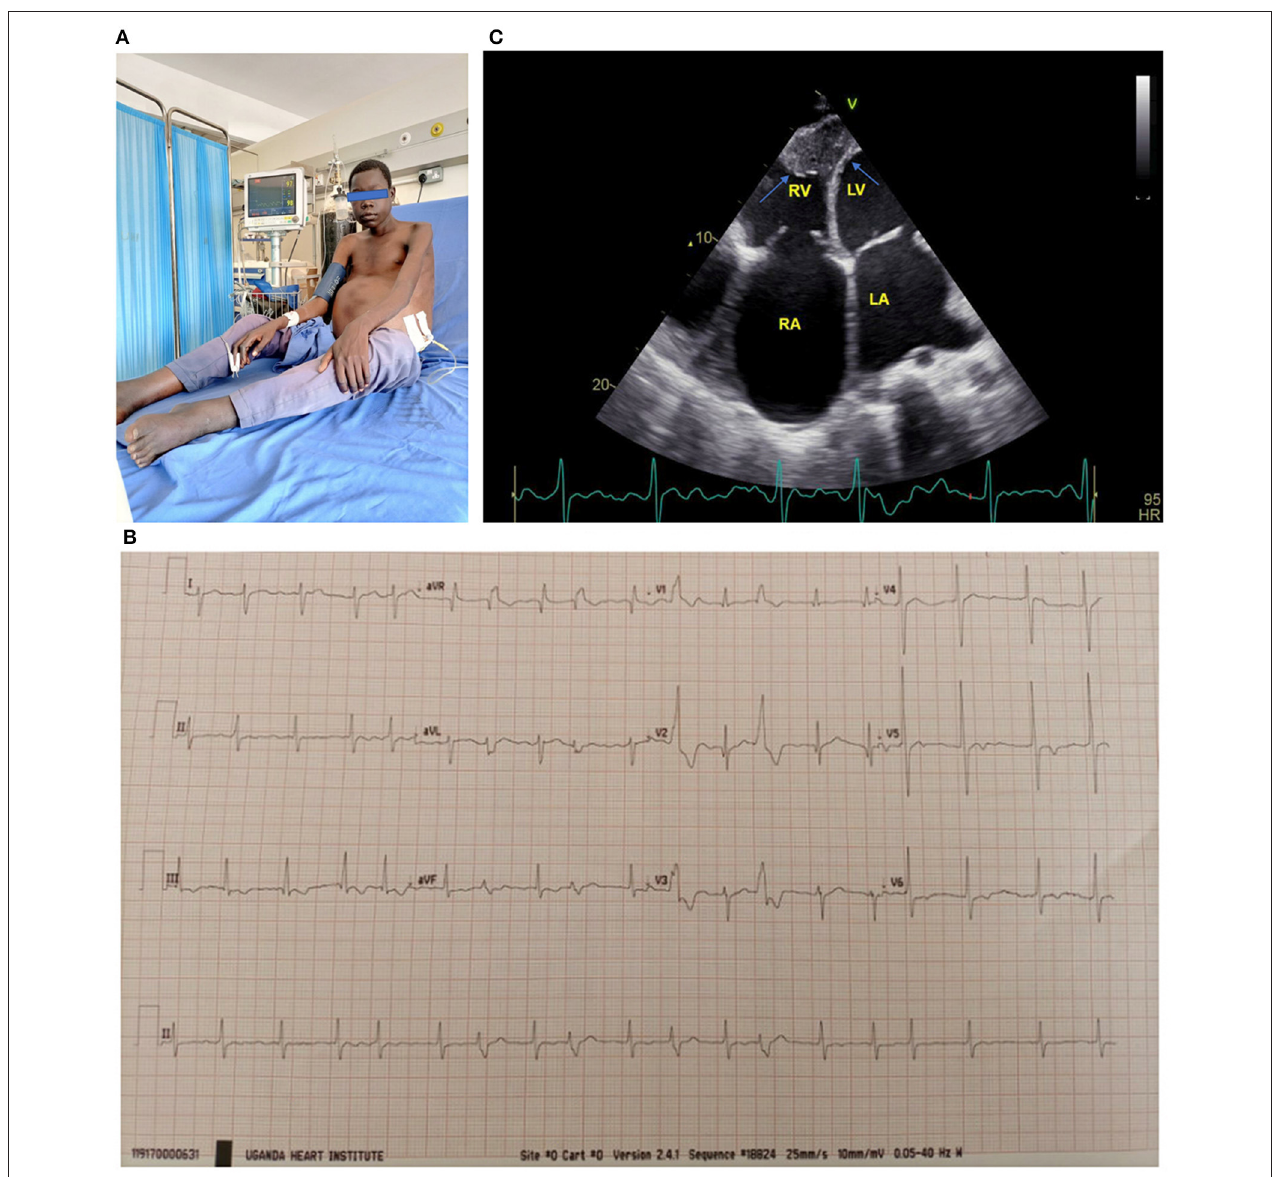
FIGURE 1 | (A) 17-year-old boy with biventricular EMF receiving paracentesis. Note the gross abdominal ascites. (B) ECG of a 17-year-old boy with biventricular EMF. Note the atrial fibrillation with rapid ventricular response and frequent premature ventricular contractions. (C) Apical 4 chamber view of a 17-year-old boy with biventricular EMF, with predominant right ventricular involvement. Note reduced RV cavity with near obliteration of the apex and fibrotic endocardium (blue arrows) and markedly dilated right atrium. The patient’s ECG tracing shows he is in atrial fibrillation. RA, right atrium; RV, right ventricle; LA, left atrium; LV, left ventricle. See the Supplementary Material for more echo images of the above